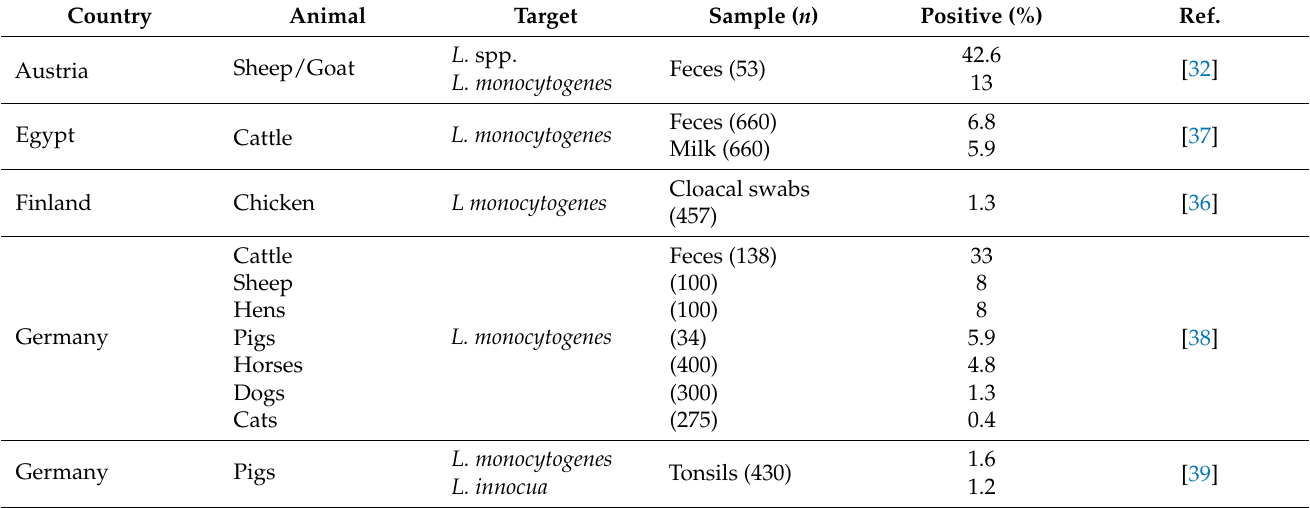
Table 1. Isolation of Listeria monocytogenes from healthy domestic